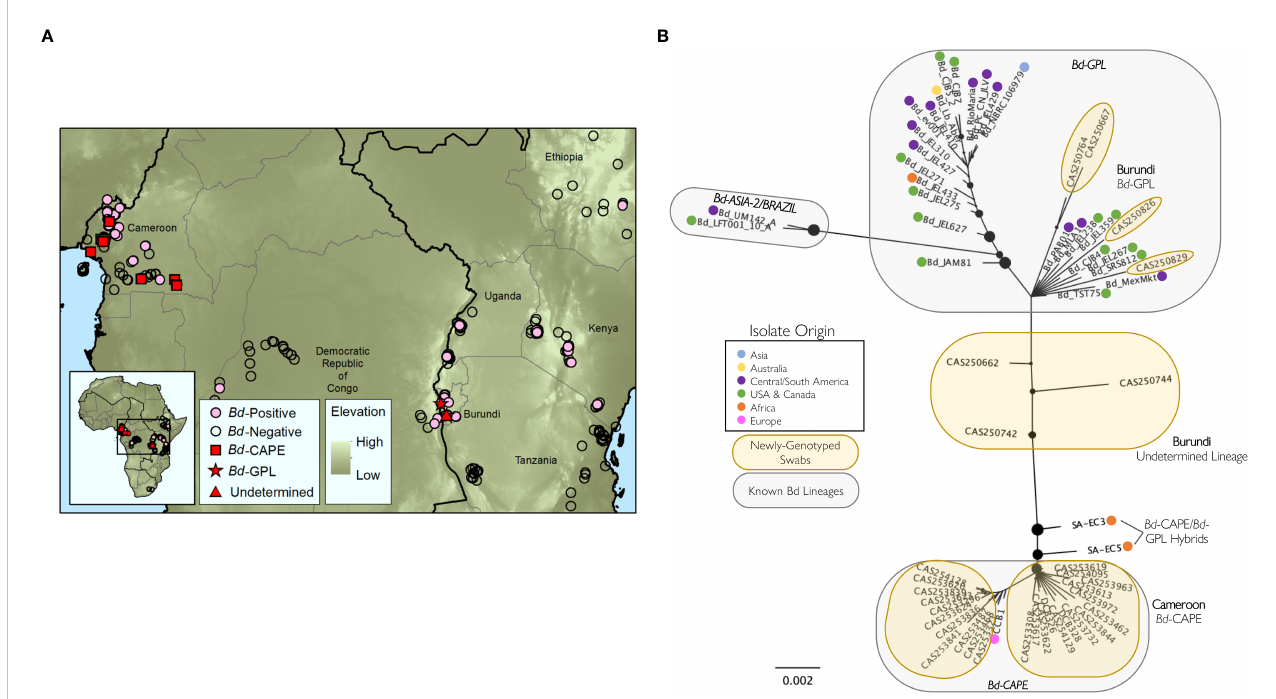
FIGURE 2 Genotyping of Batrachochytrium dendrobatidis (Bd) lineages from samples processed in this study. (A) Locations and infection status of georeferenced samples processed by the authors of this study (N=4,349) showing Bd -positive (pink circles) and Bd -negative (open circles) locations; locations of Bd samples genotyped in this study (N=32) are indicated by red squares ( Bd -GPL), red stars ( Bd -CAPE), and red triangles (Undetermined lineage); (B) best- scoring unrooted maximum likelihood tree for 61 Bd samples (32 sequenced for this study, 31 previously-published Bd isolates). Tree created from concatenated, aligned consensus sequences from 186 Bd loci (25,617 bp). Nodes with less than 10% bootstrap support have been collapsed and the size of the black node markers are scaled based on bootstrap support. Geographic origin for each previously published isolate is indicated with a colored dot. Known Bd lineages are inside grey circles and samples genotyped for this study are in yellow circles. See Table S4 for sample information associated with the newly genotyped